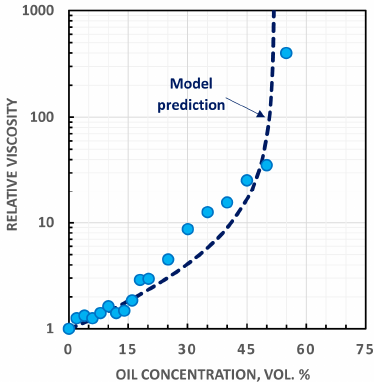
Figure 10. Comparison of the experimental relative viscosity data for Pickering O/W emulsions with the predictions of the proposed model.